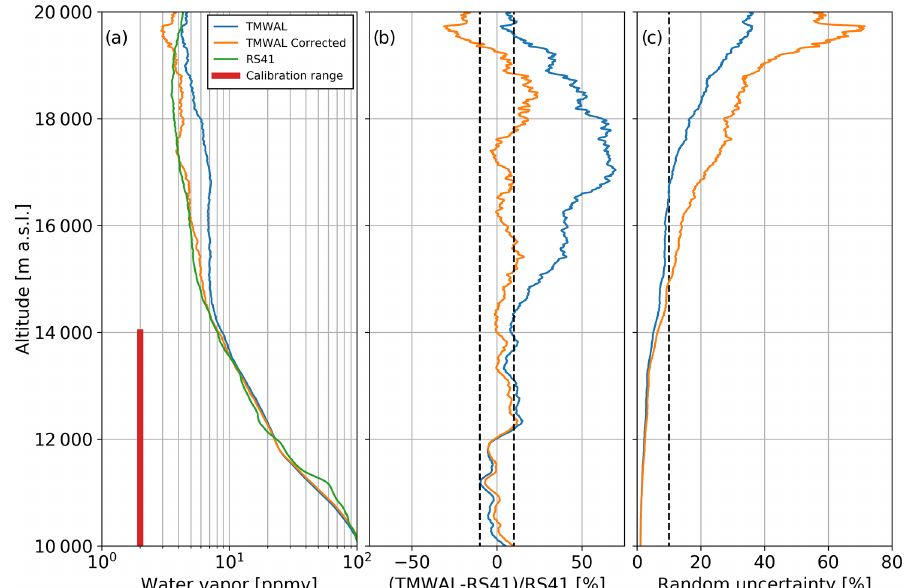
Figure 6. (a) The average of the 22 profiles measured between 27 August and 4 November 2021 by TMWAL before the correction method was applied (solid blue line) and after the correction method was applied (solid orange line) are shown together with the average of the co-located RS41 radiosonde profiles (solid green line). The retrieved TMWAL profiles are calibrated using the RS41 measurements between 9 and 14kma.s.l. (red stripe). (b) Average of the relative difference between the uncorrected (solid blue line) and corrected (solid orange line) TMWAL profiles when compared with the co-located RS41 launches. (c) Average random uncertainty (1 σ ) for the uncorrected (solid blue line) and corrected (solid orange line) TMWAL